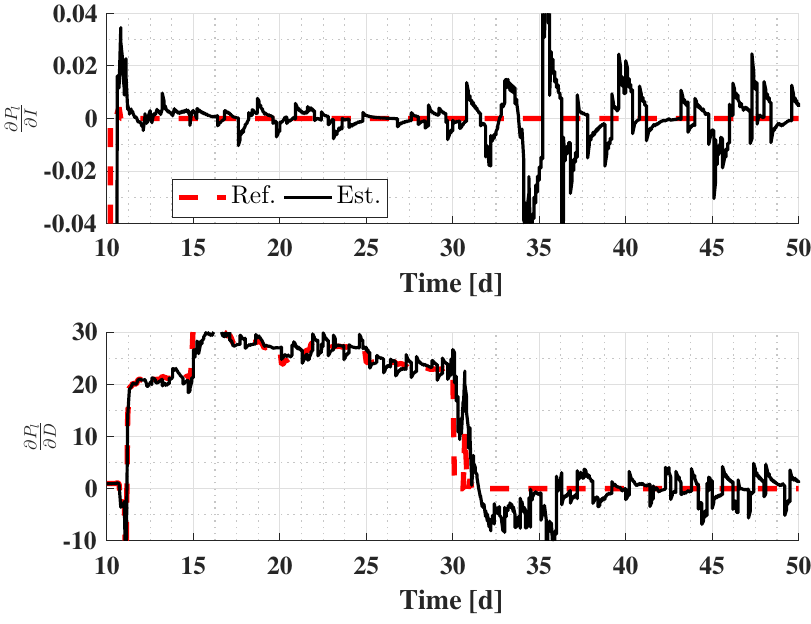
Figure 6. Time evolution of the estimated gradient ∂ P l